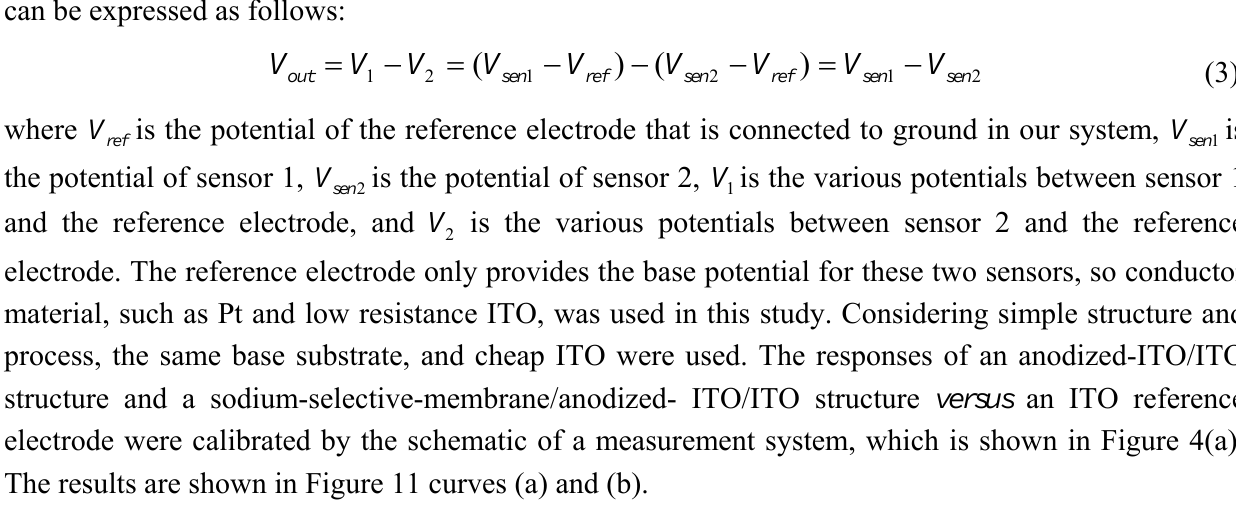
Figure 11. Sodium sensitivities of (a) the sodium-selective-membrane/anodized-ITO/ITO structure, (b) the anodized-ITO/ITO structure, and (c) the calculation of